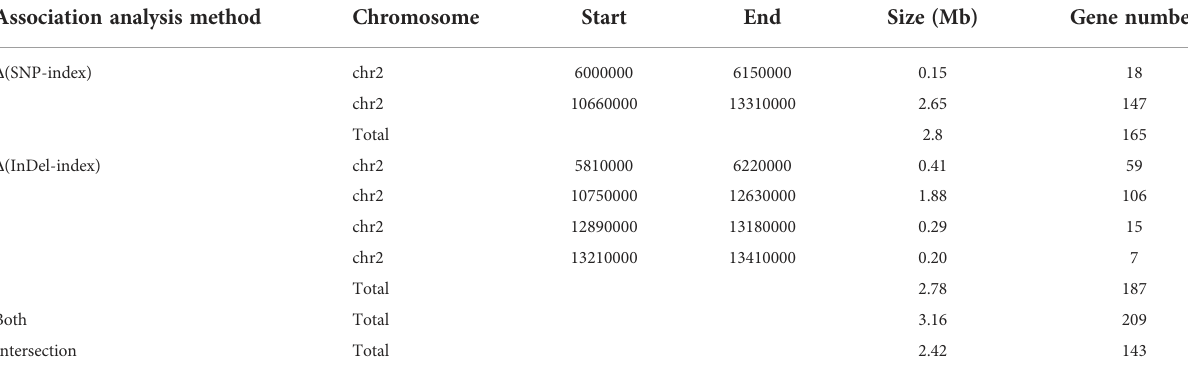
TABLE 4 Candidate genomic regions identi fi ed by association analysis of